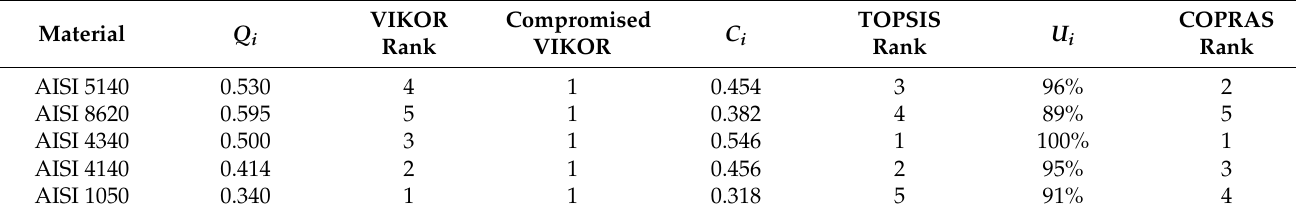
Table 18. Ranking with subjective weight.